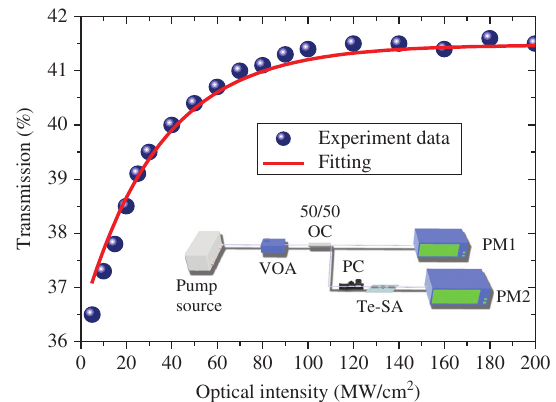
Figure 6: Power-dependent nonlinear optical property of tellurene- based SA. optical property.